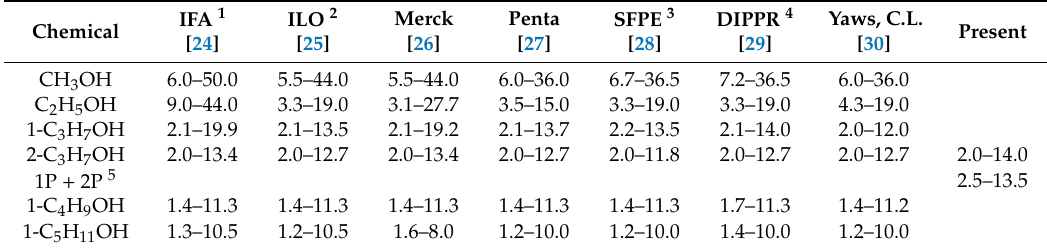
Table 7. Presented and published explosion ranges (in